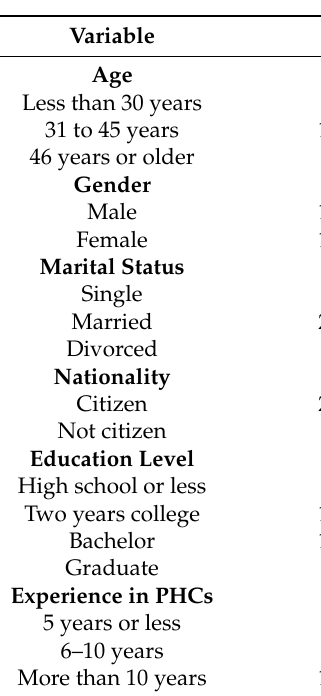
Table 1. Demographic